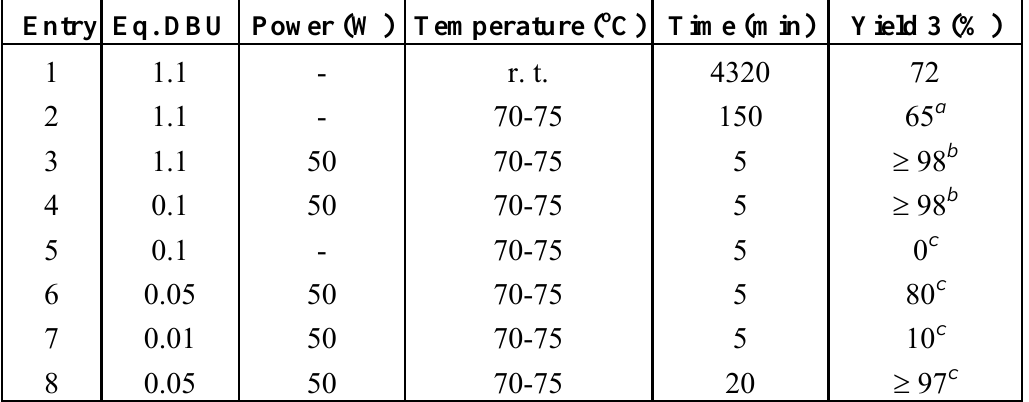
a Reaction was performed under conventional conditions and the yield was obtained after purification in column chromatography. b Reaction was performed under microwave irradiation and the yield was obtained after product by column chromatography. c Obtained by 1